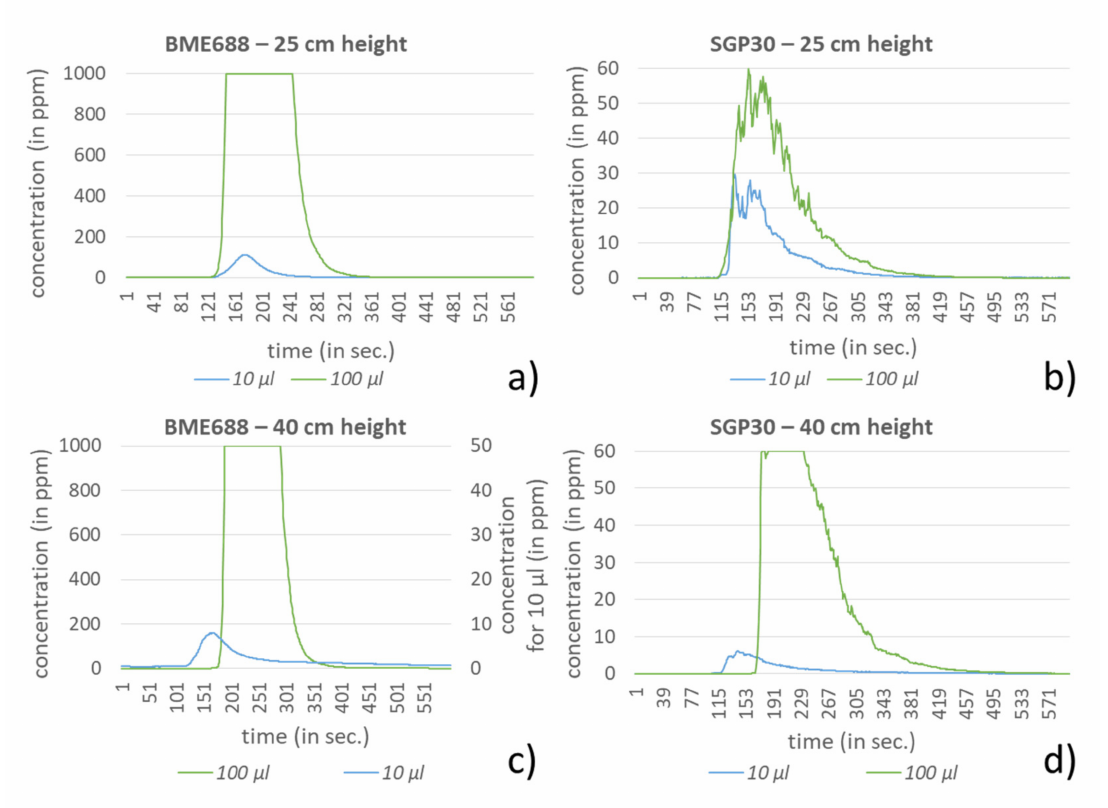
Figure 9. Response of BME688 and SGP30 for different amounts of ethanol and for 25 and 40 cm height above the emission source (consider the second ordinate axis in c) for 10 µ L). In ( a ) a measurement height of 25 cm for BME688 and ( b ) for SGP30 is used. In ( c ) the measurement height was changed to 40 cm for BME688 and ( d ) for